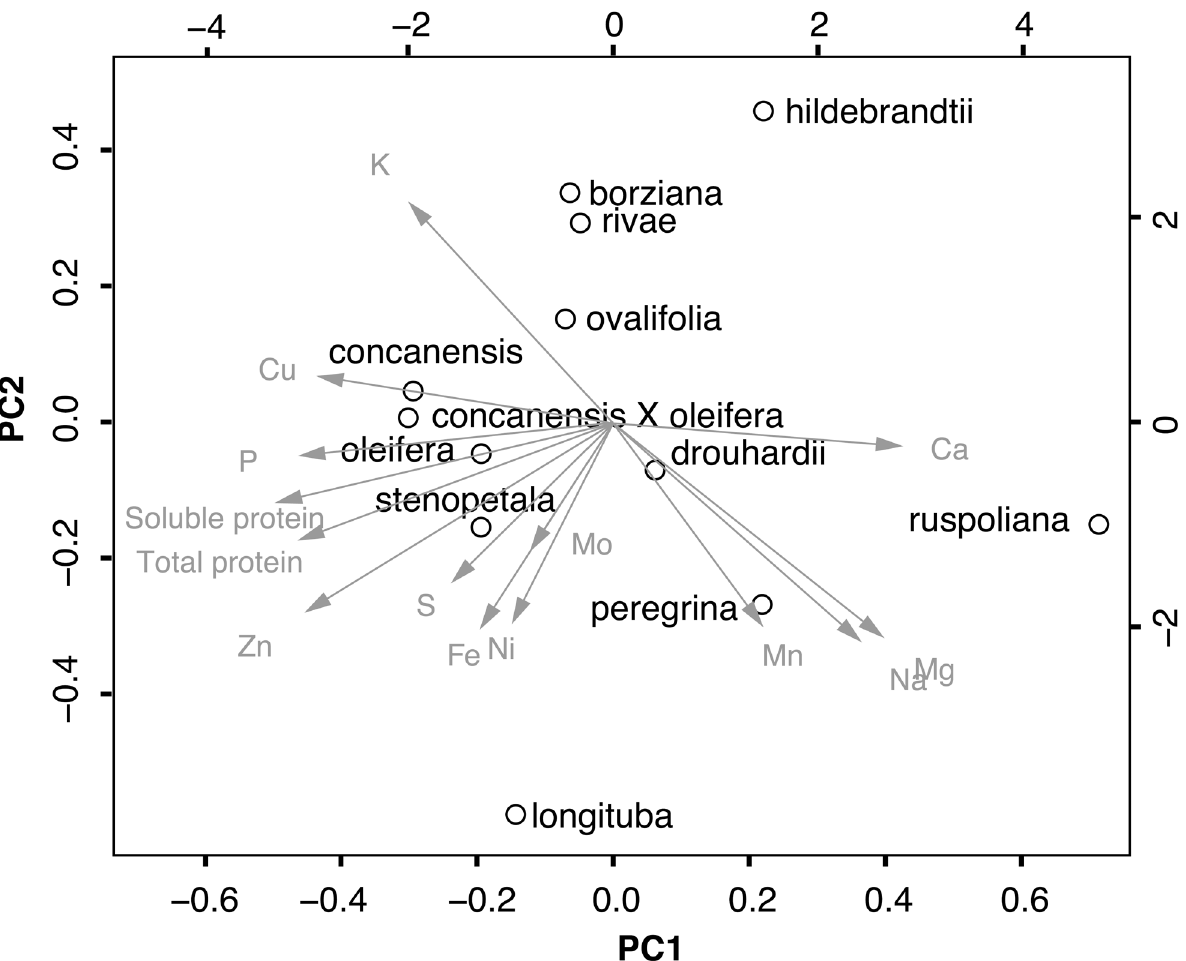
Fig 3. Plot of the first two principal components of the PCA of Moringa protein, macro- and micro- nutrient variation across